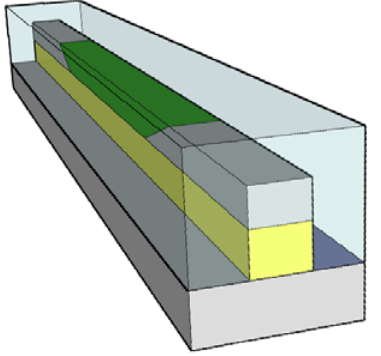
Figure 3. Hybrid sol-gel/polymer waveguides. The core of the sol-gel waveguide is shown in yellow, the electro-optic (EO) polymer layer—in green, gray—low refractive index sol-gel